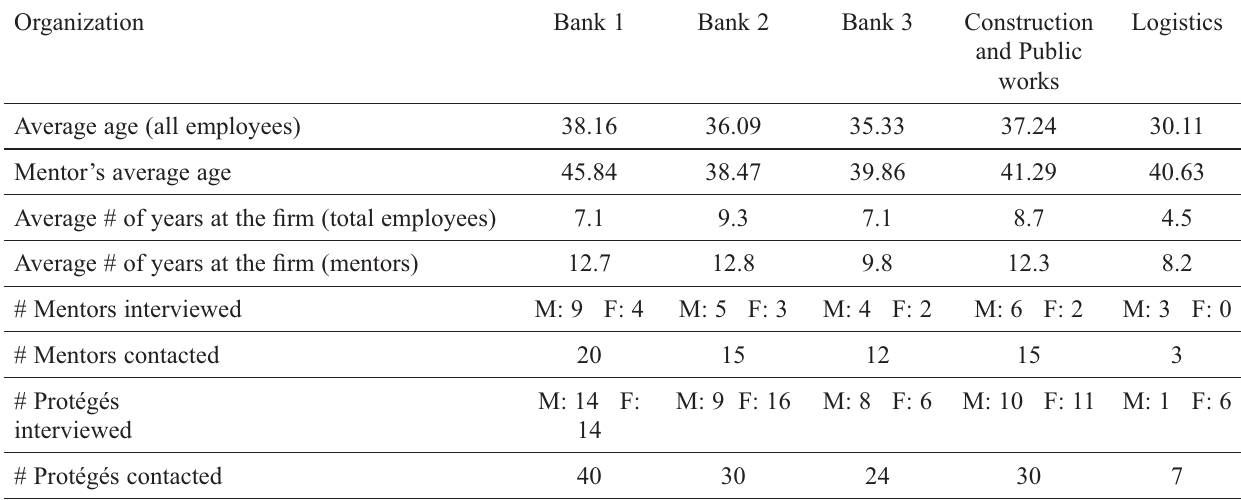
Table 2 . The interviewees in fi gures